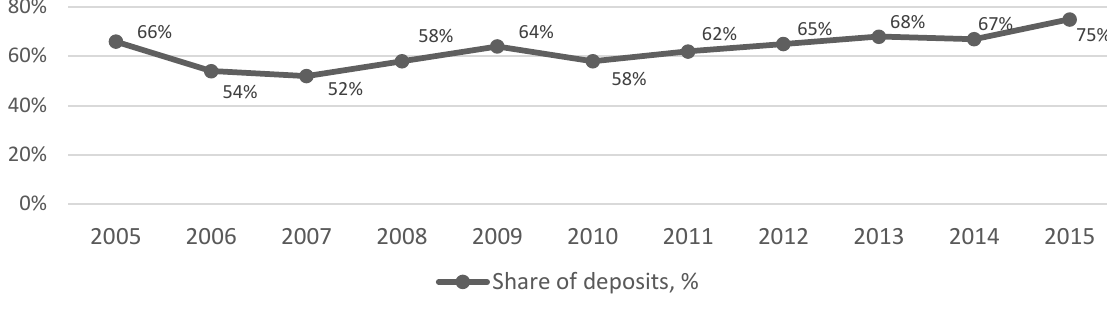
Figure 3. Analysis of bank